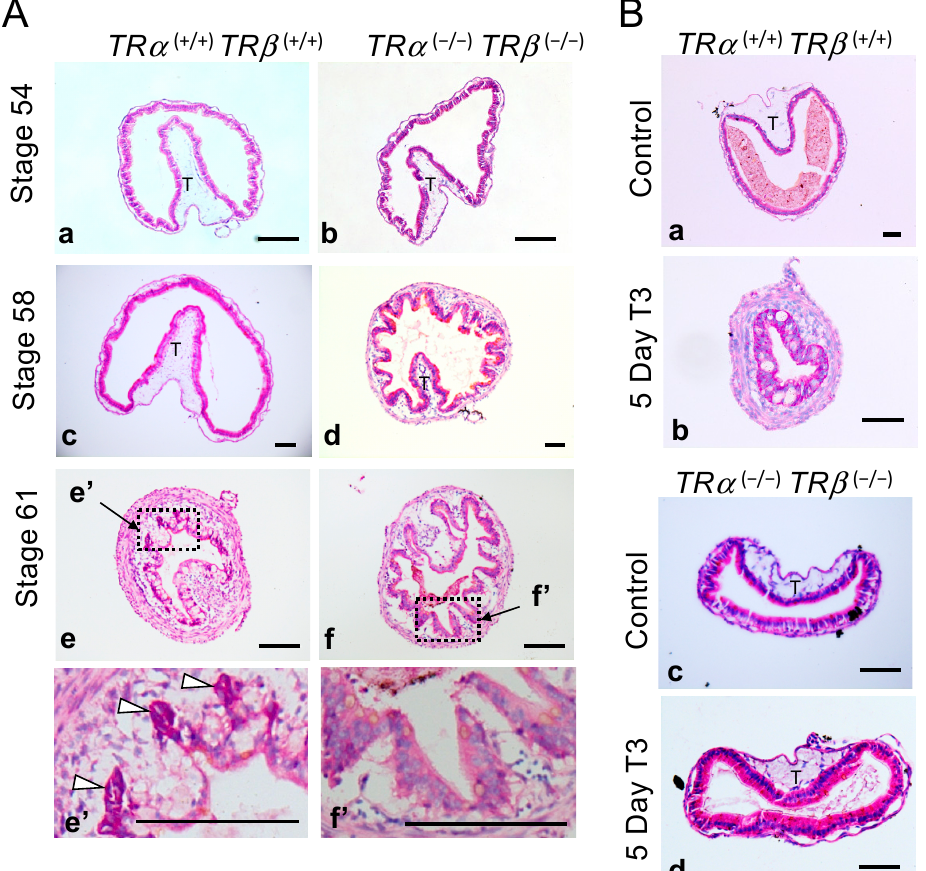
Figure 2. TRDKO tadpoles have abnormal intestinal morphology with apparent adult type epithelial folding by stage 58. ( A ) Abnormal intestinal morphology in TRDKO tadpoles. Cross-sections of the intestine isolated from tadpoles at the indicated stages were stained with MGPY (methyl green-pyronin Y). ( a , c , e ): Wild-type TR α (+/+) TR β (+/+) ; and ( b , d , f ): TR double knockout (TRDKO ) TR α ( − / − ) TR β ( − / − ) . Dashed boxes in e and f for stage 61 are shown in higher magnification in e’ and f’ , respectively. White arrowheads point to the clusters of proliferating adult epithelial stem cells adjacent to/underlying the degenerating larval epithelium (vacuole-like, poorly stained) at the climax of metamorphosis (stage 61) in wild-type animals. Note that the knockout tadpoles lacked such clusters at stage 61 and the epithelium appeared to be uniform without any obvious degeneration throughout the stages, but with numerous folds by stage 58. T: typhlosole. Bars: 100 µ m. ( B ) TRDKO intestine does not have T3-induced tissue remodeling. Cross-sections of the intestine isolated from stage 54 tadpoles with or without 5 days T3 treatment were stained with MGPY. ( a , b ): TR α (+/+) TR β (+/+) ; and ( c , d ): TR α ( − / − ) TR β ( − / − ) . Note that after T3 treatment, the wild-type intestine resembled that at stage 61 (climax of intestinal remodeling), while no T3-induced changes were present in the TRDKO tadpole intestine. T: typhlosole. Bars: 100 µ